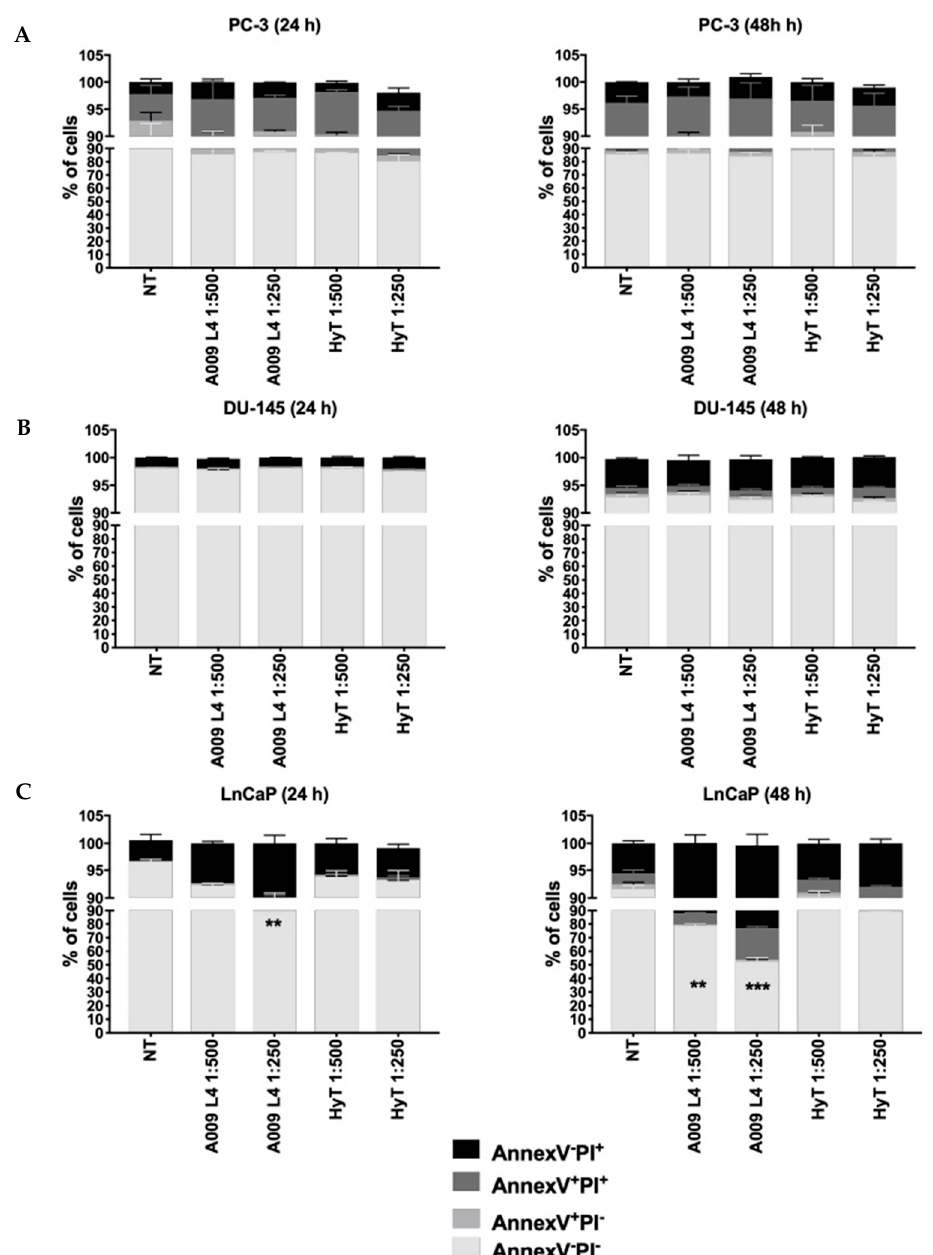
Figure 2. Effects of A009 (L4) on PC-3, DU-145 and LNCaP apoptosis. Apoptosis (24 and 48 h) was assessed by flow cytometry on PC-3 ( A ), DU-145 ( B ), and LNCaP ( C ) human prostate cancer cells. Induction of specific apoptosis phases was detected by gating annexin V − /PI − cells (viable), annexin V + /PI − cells (early apoptotic), annexin V + /PI + cells (late apoptotic) and annexin V − /PI + cells (dead). EtOH diluted (1:500 and 1:250) in complete RPMI was used as control vehicle for HyT, with no effects on induction of apoptosis (data not shown). Results are shown as mean ± SEM, ANOVA, ** p < 0.01, *** p < 0.001.